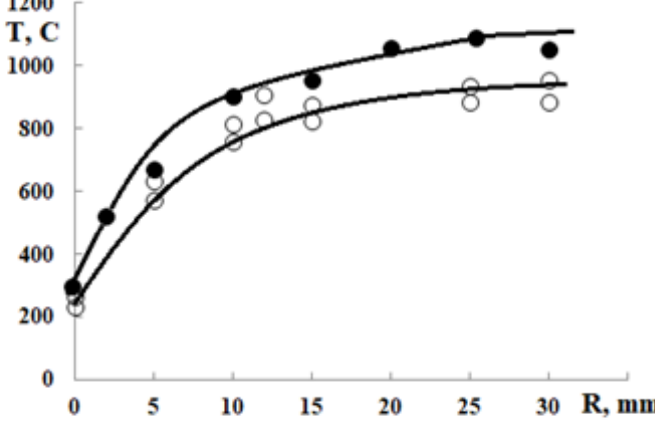
Figure 6. Radial distribution of gas temperature leaving the plasma-chemical reactor. White dots—when working with zeolites; black dots—with clay. The air flow through the plasma torch was 1 g/s, and the protective gas was 2.63 g/s.